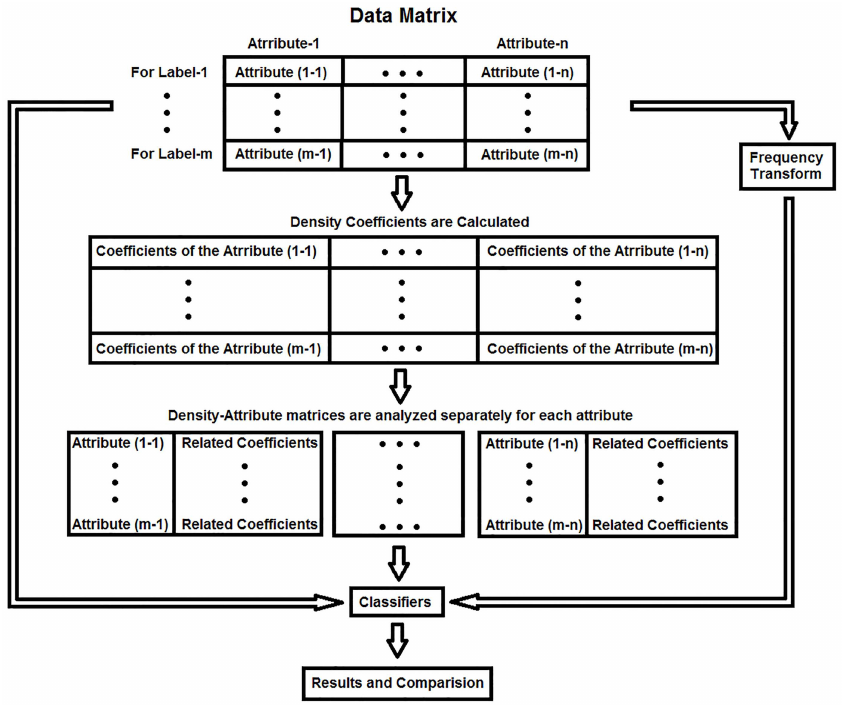
Fig 2. Flow diagram of the study (Attribute (m-n) means the class m data in the nth